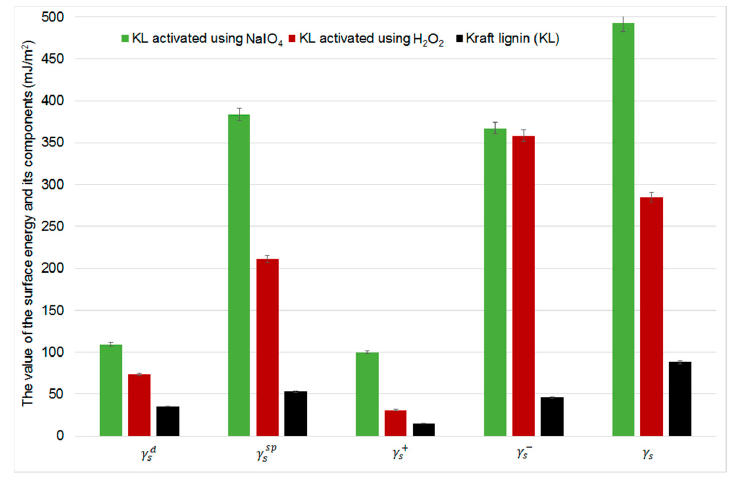
Figure 9. Surface free energy and its components for kraft lignin samples.